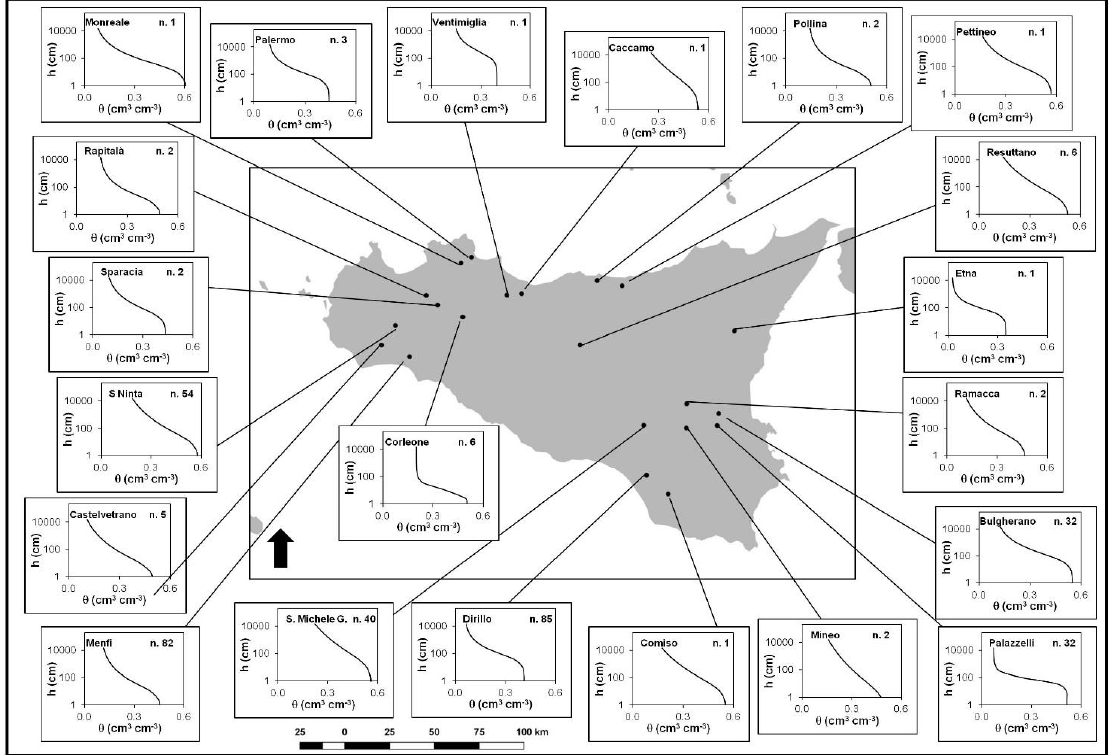
Figure 2. Mean soil water retention curve according to the van Genuchten (vG) model (Equation (2)) at each investigated Sicilian site; n is the number of sampled soils at each site.